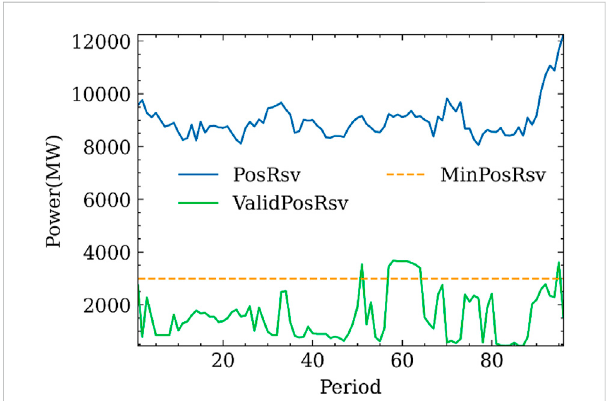
FIGURE 9 Comparison diagram of system positive reserve, effective positive reserve, and positive reserve demand.